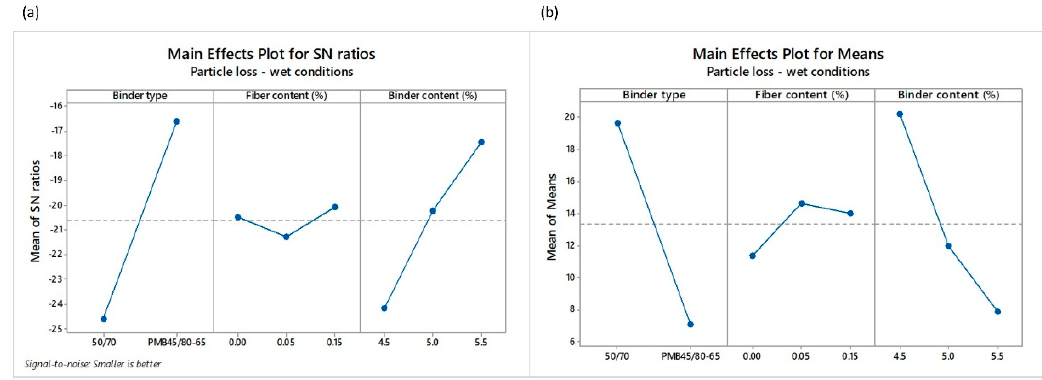
Figure 7. Main effects plots of ( a ) SNR and ( b ) means of the particle loss in wet conditions 𝑃𝐿 (cid:3024)(cid:3006)(cid:3021) .